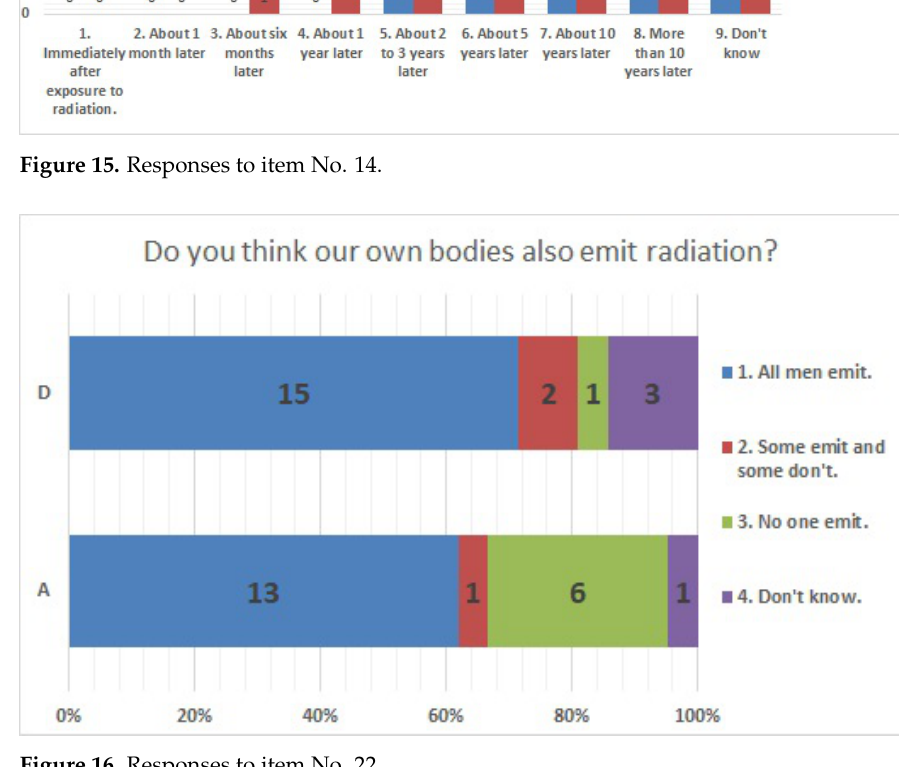
Figure 16. Responses to item No. 22.